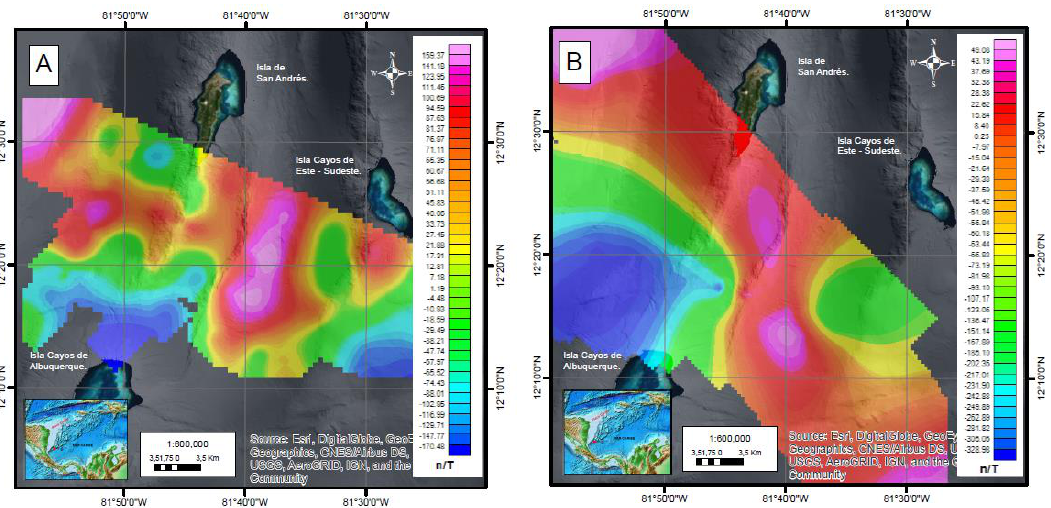
Figure 14. Geomagnetic surfaces of the total field. ( A ) Surveyed magnetic field. ( B ) Magnetic field from data downloaded from the NOAA.